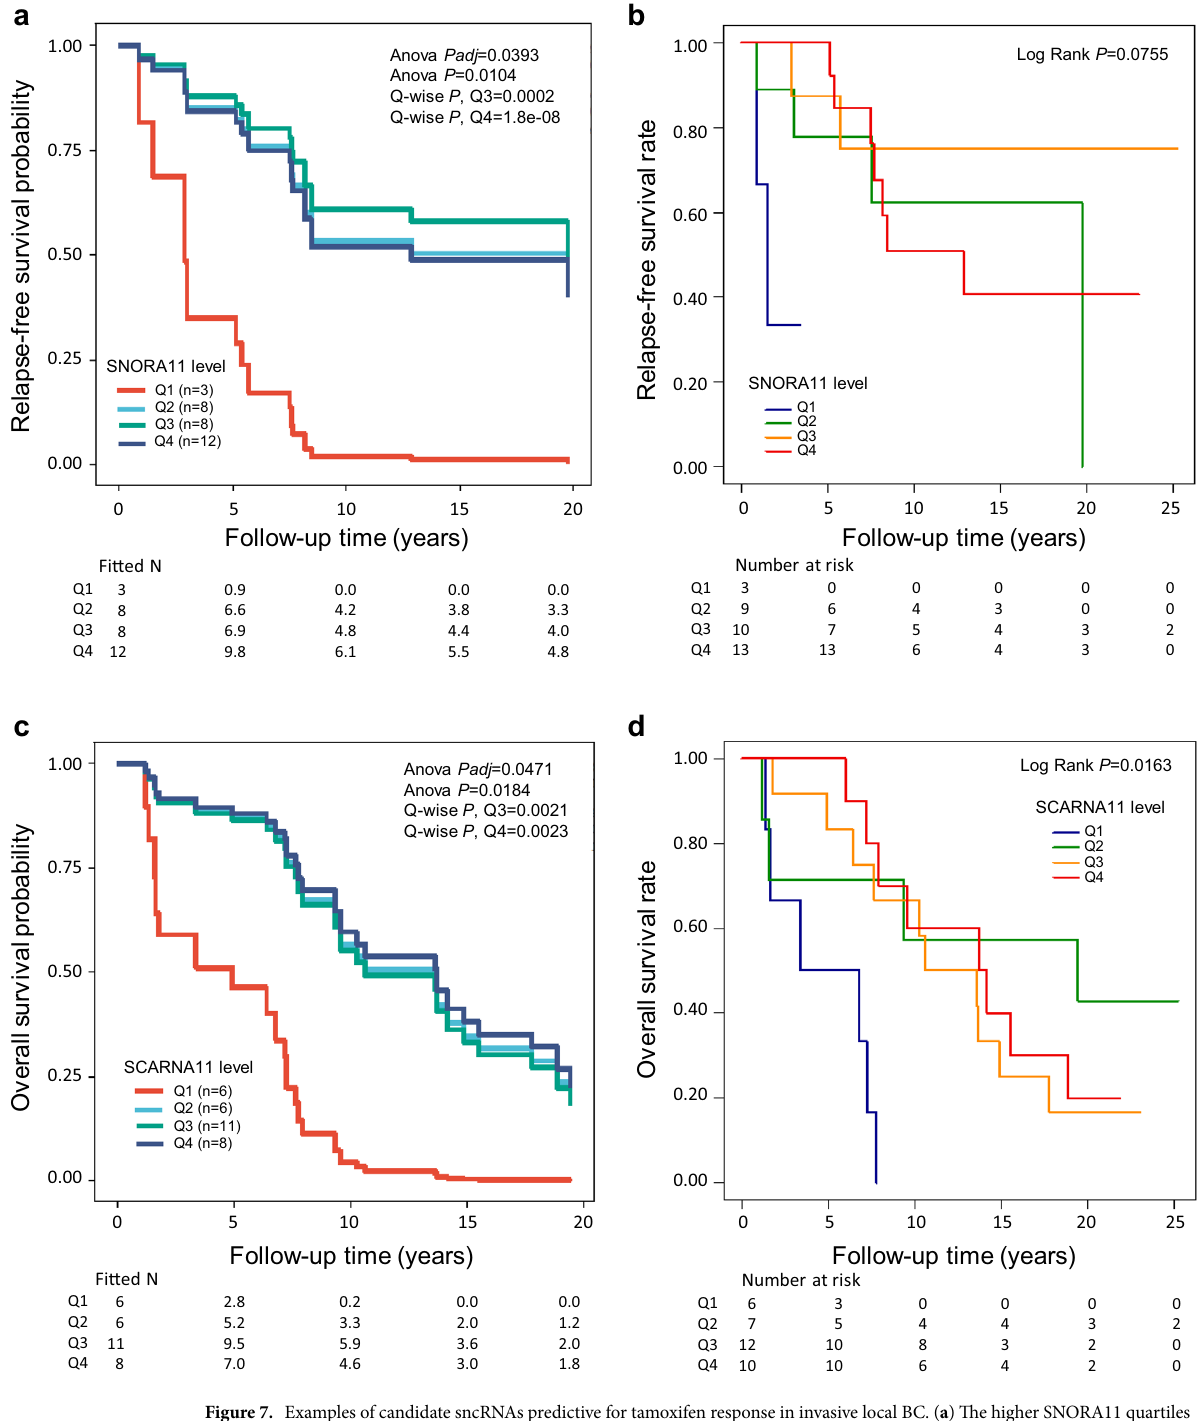
Figure 7. Examples of candidate sncRNAs predictive for tamoxifen response in invasive local BC. ( a ) The higher SNORA11 quartiles (Q3 and Q4) significantly associated with better RFS in the Cox multivariate analysis including the covariates tumor grade, histology and size, nodal status, PR status, HER2 status, age at diagnosis, and RT (yes/no) (Overall Padj = 0.0393, Overall P = 0.0104, for Q3 P = 0.0002, HR [CI 95%] = 0.05 [0.01–0.24], and for Q4 P = 1.8e − 08, HR [CI 95%] = 0.02 [0.01–0.08]), when compared to the lowest quartile (Q1) in the cases with ER positive BC who had received tamoxifen (invasive local, n = 31). ( b ) Kaplan–Meier plot showing the association of SNORA11 with RFS in the univariate analysis (Overall Log Rank P = 0.0755) in the tamoxifen-treated cases with invasive local, ER positive BC (n = 35). Note the low number of events in the Q1 group. ( c ) The higher SCARNA11 quartiles (Q3 and Q4) significantly associated with better OS in the Cox multivariate analysis including the covariates tumor grade, histology and size, nodal status, PR status, HER2 status, age at diagnosis, and RT (yes/no) (Overall Padj = 0.0471, Overall P = 0.0184, for Q3 P = 0.0021, HR [CI 95%] = 0.13 [0.04–0.48], and for Q4 P = 0.0023, HR [CI 95%] = 0.12 [0.03–0.47]), when compared to the lowest quartile (Q1) in the cases with ER positive BC who had received tamoxifen (invasive local, n = 31). ( d ) Kaplan–Meier plot showing the association of SCARNA11 with OS in the univariate analysis (Overall Log Rank P = 0.0163) in the tamoxifen-treated cases with local invasive, ER positive BC (n = 35). In ( a ) and ( c ), the fitted Ns were extrapolated from the multivariate-fitted survival probabilities. Note that the last time point in ( a ) is at 19.74 and in ( c ) 19.43